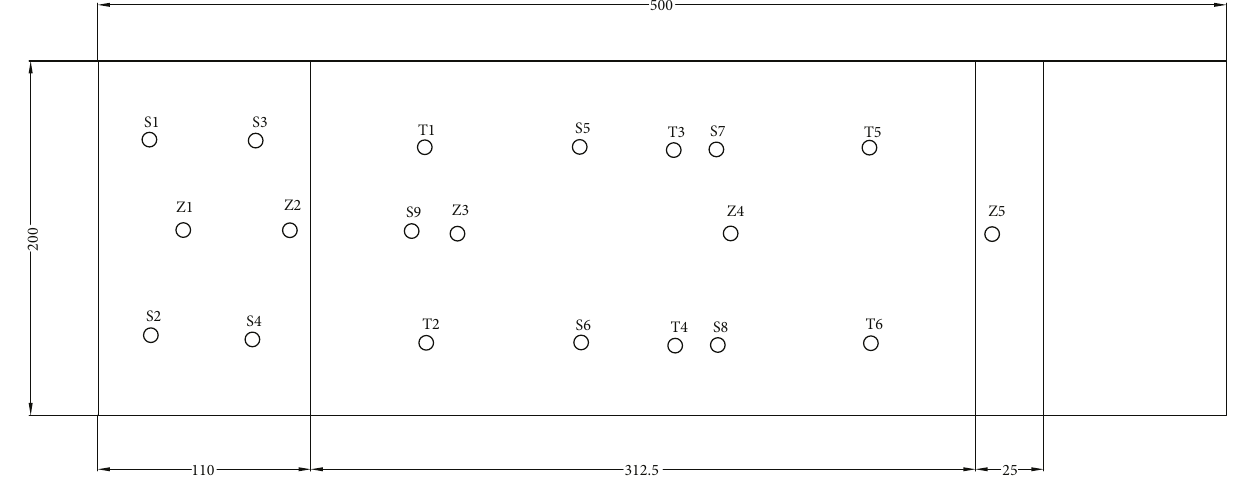
Figure 4: Top view of sensor embedding (unit: cm). S: osmometer, Z: matric suction sensor, and T: soil pressure gauge.